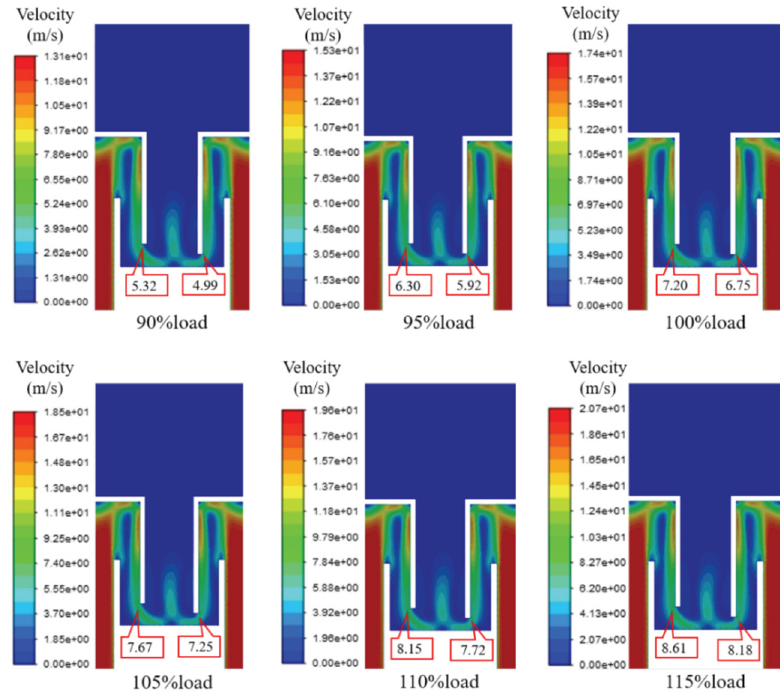
Fig. 7. Cloud diagram of the fl ow rate distribution under different algorithm based on pressure correction and second-order